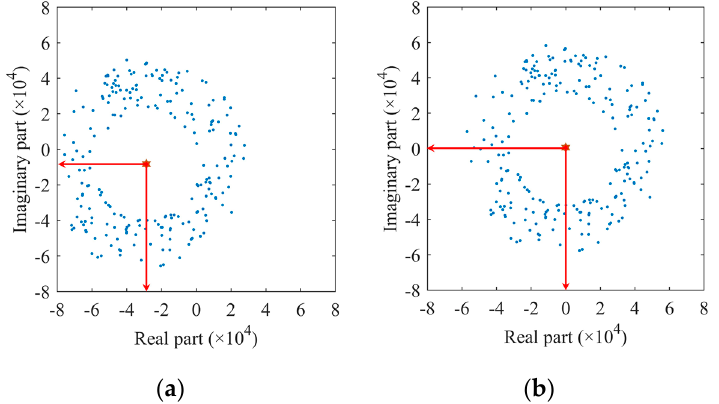
Figure 3. The complex data at the selected range bin: ( a ) before DC offset compensation; ( b ) after DC offset compensation.